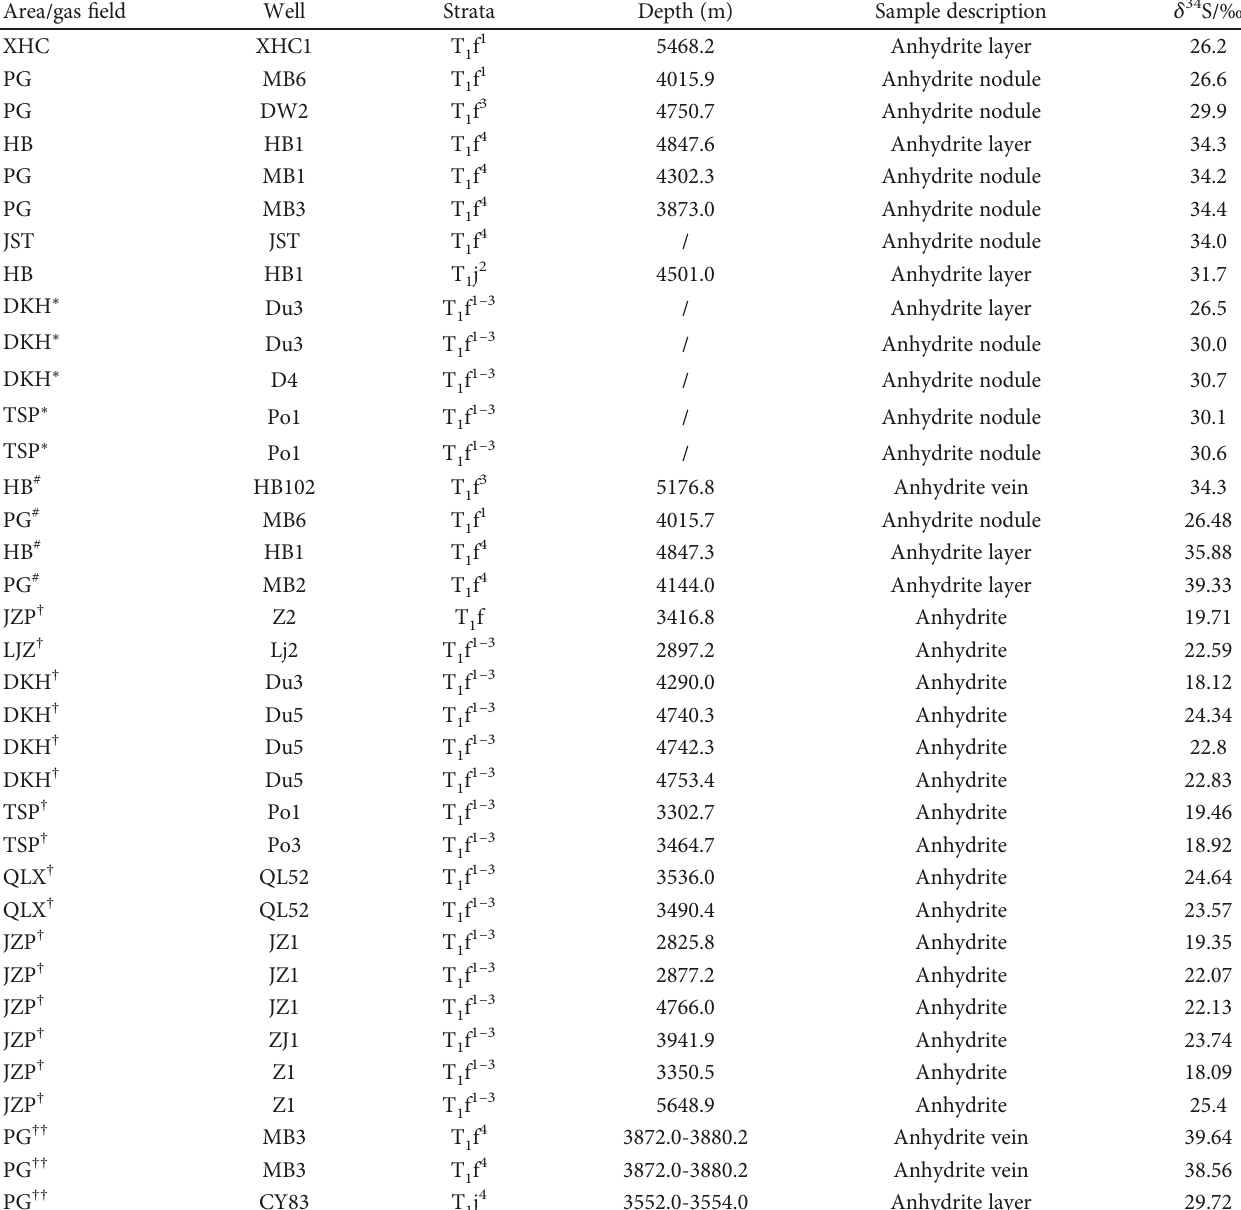
Table 2: Sulfur isotope compositions of anhydrite from the northeastern Sichuan Basin. Area/gas fi